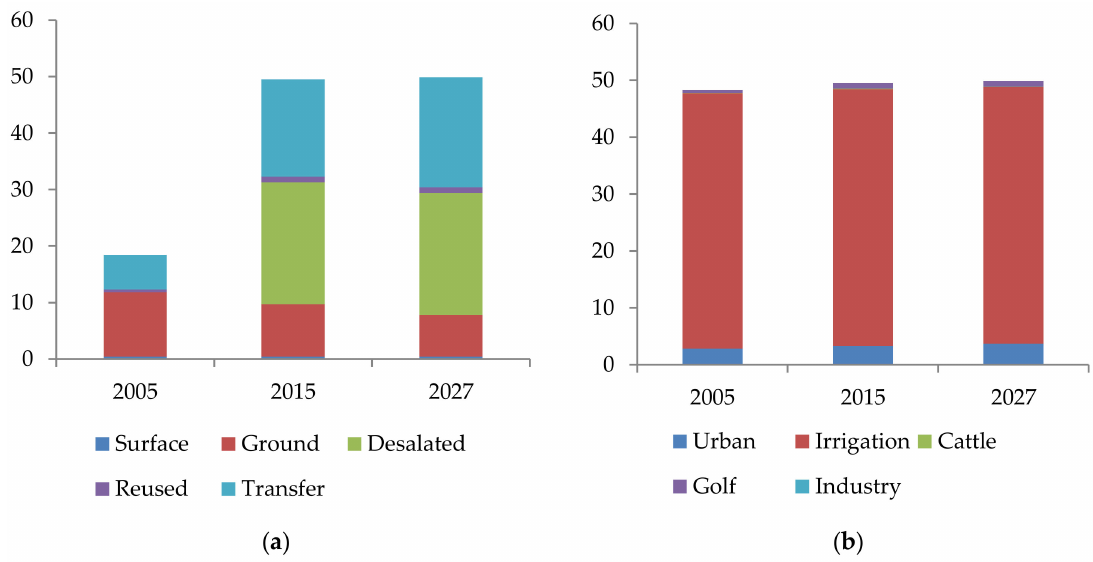
Figure 1. ( a ) Water sources in the basin of Campo de N í jar (hm 3 ) *; ( b ) Demands of water from the basin of Campo de N í jar by sectors (hm 3 ) *. * Adapted from the Hydrological Plan for the Andalusia Mediterranean Basin (Plan Hidrol ó gico de la Demarcaci ó n Hidrogr á fica de las Cuencas Mediterr á neas